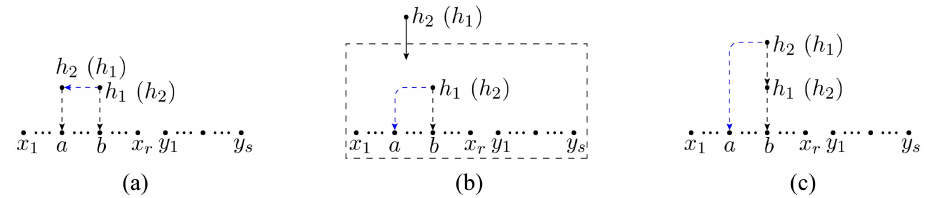
Figure 12 . (a): all two-graviton graphs with h 1 ( h 2 ) as starting node pointing towards gluon a via one or two type-4 edges, (b): the spanning forests for the two-graviton Hodges determinant, accompanied by a type-3 edge e ( b, a ) .